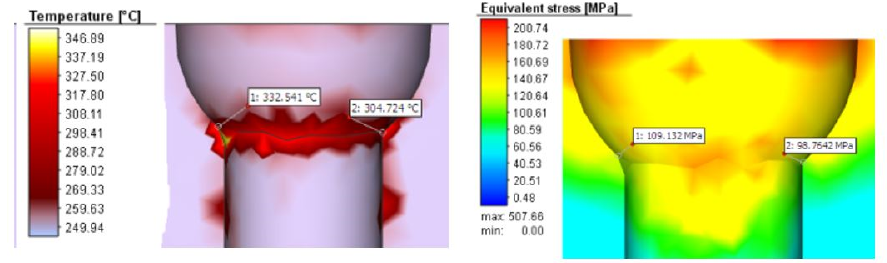
Figure 8: Analysis of temperature and equivalent stress of upper die at points 1 and